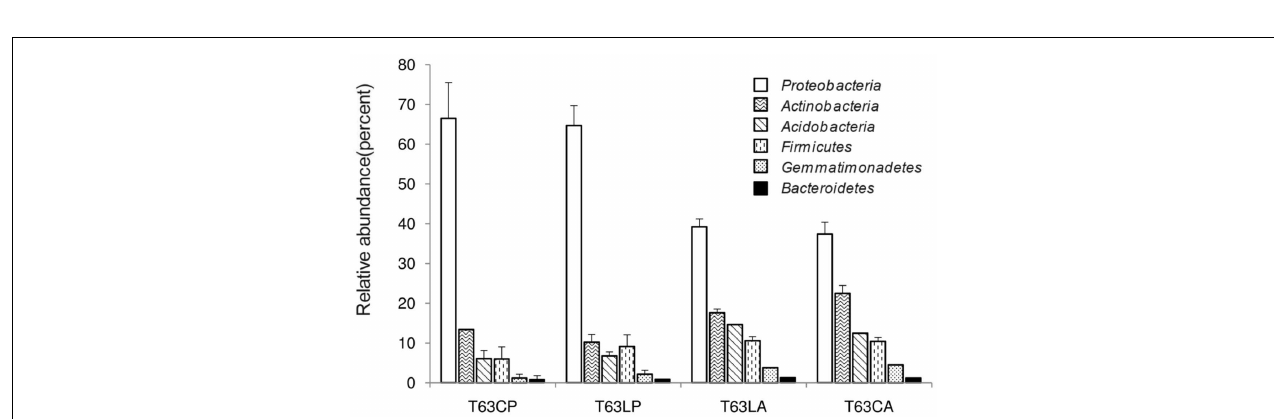
FIGUREA4 | Bacterial DGGE fingerprint (A,C) and the corresponding UPGMA clusters (B,D) for soil spiked with phenanthrene (LP: phenanthrene-spiked Luvisol, CP: